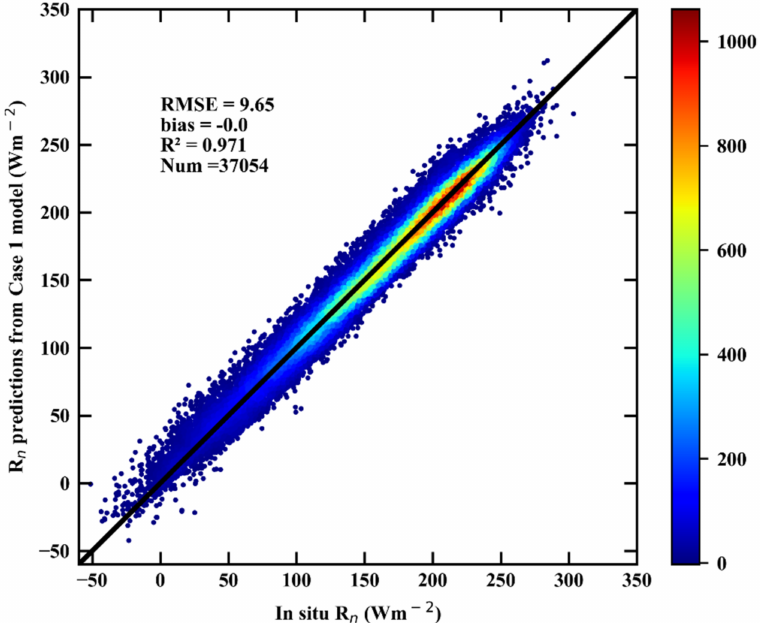
Figure 5. Fitting results of the Case 1